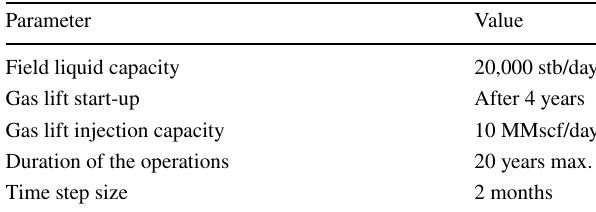
Table 2 Parameters used in the reference case